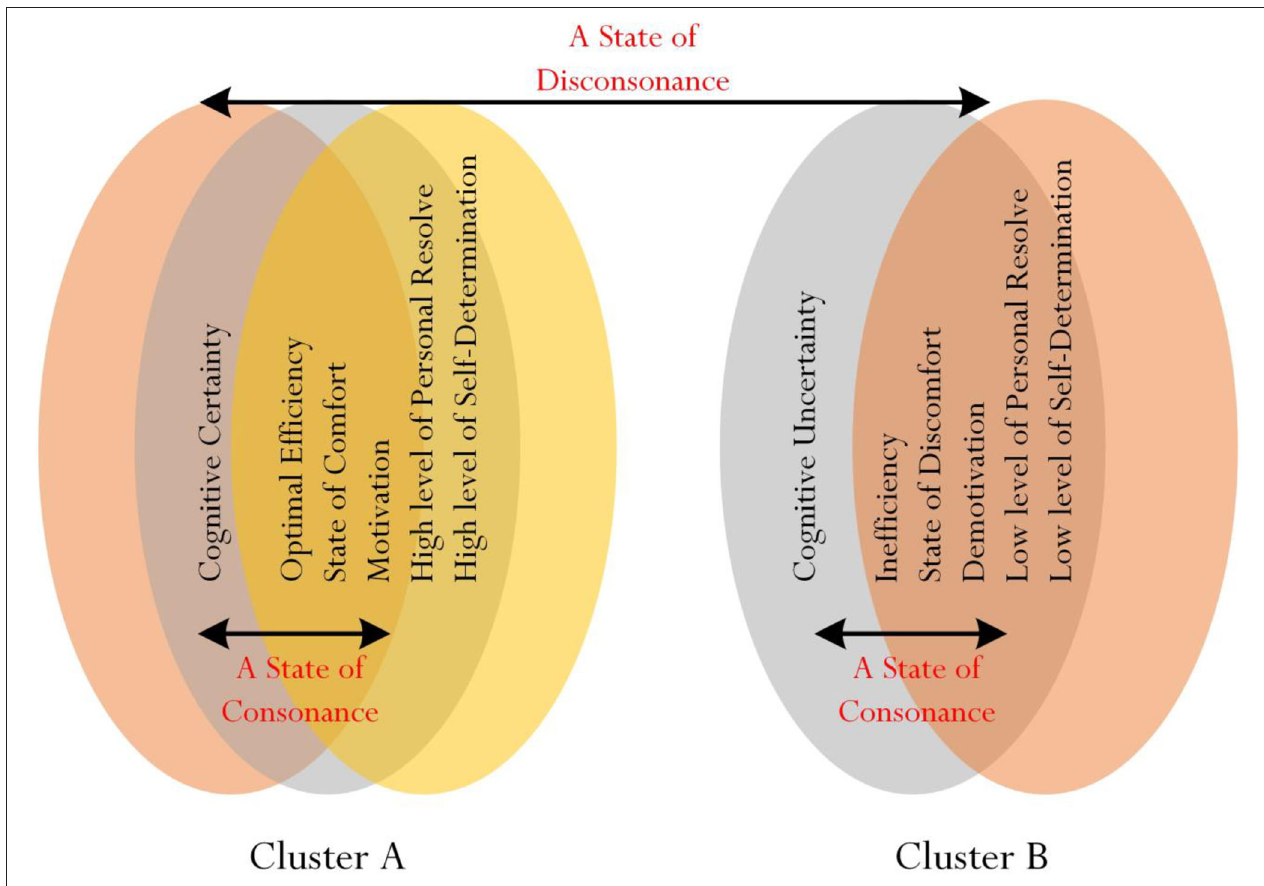
FIGURE 5 | Proposition of clustering for cognitive certainty and cognitive